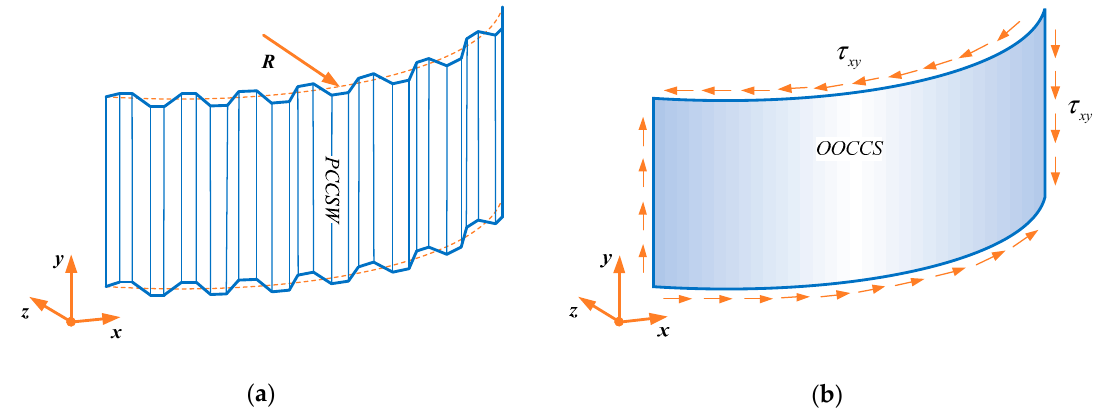
Figure 3. Plane curved CSW and its equivalent model: ( a ) Plane curved corrugated steel web; ( b ) Equivalent orthotropic shell. PCCSW: plane curved corrugated steel web.